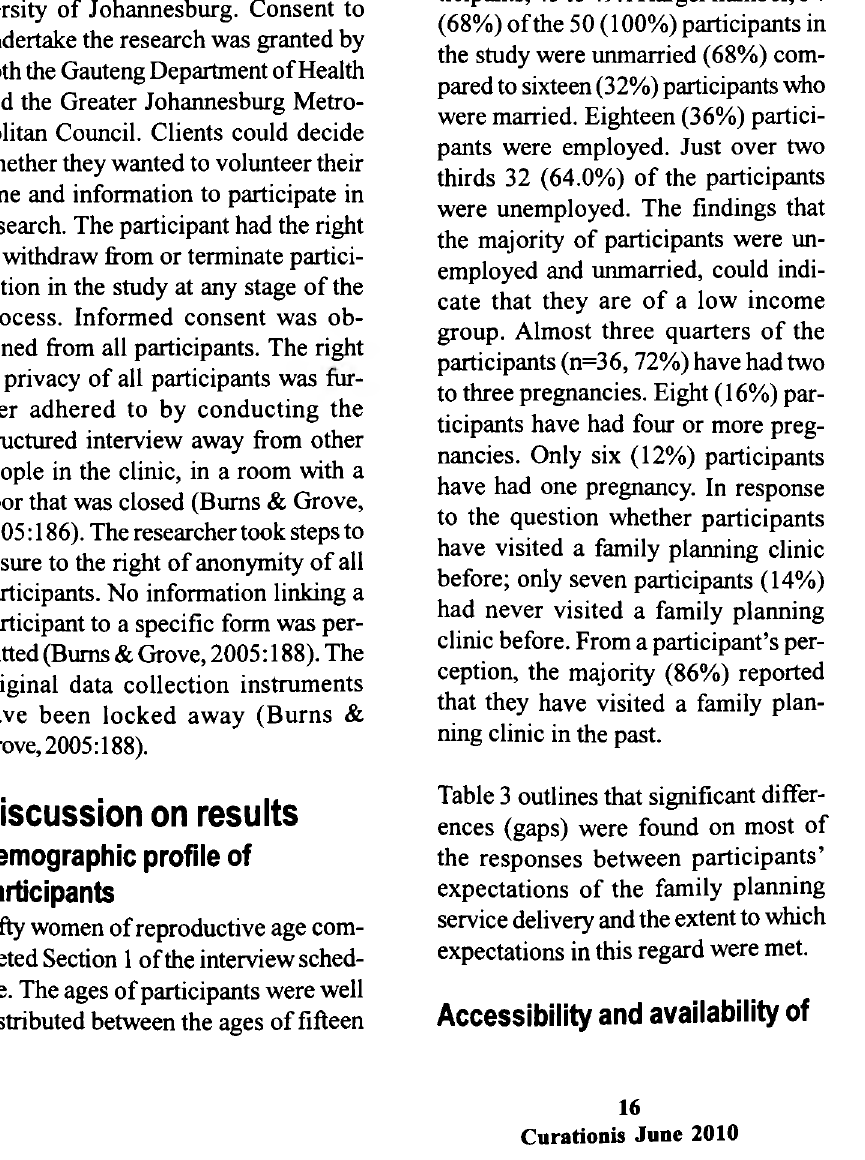
Test Value = 4.00 95% Confidence Interval of the Difference Lower Upper ence